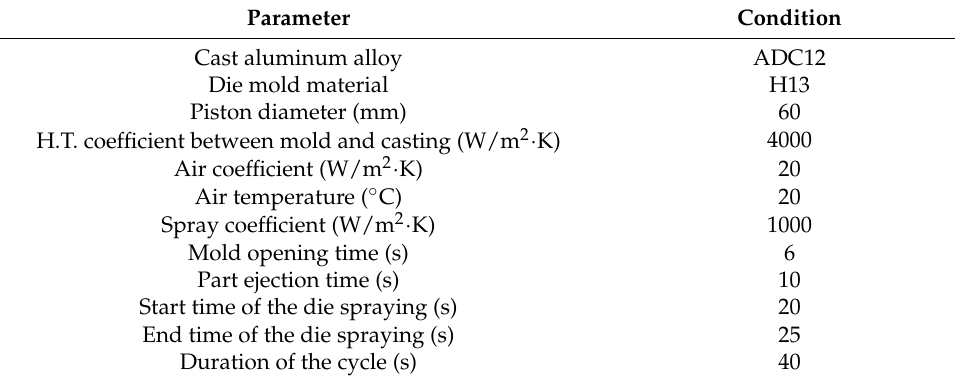
Figure 3. Components and meshes of the numerical simulation model. Table 3. The initial and boundary conditions of the HPDC process.